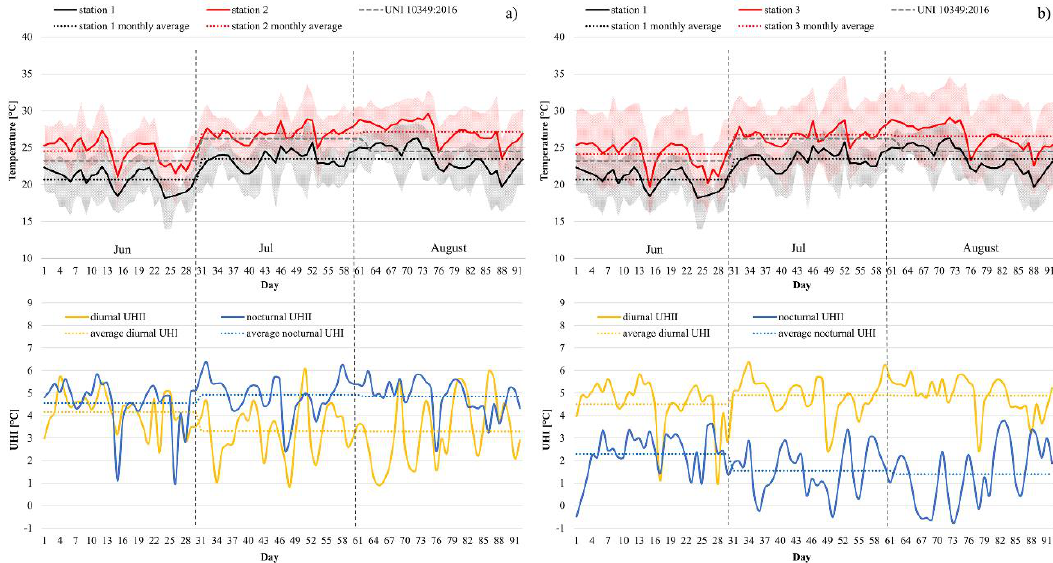
Figure 9. ( a ) Diurnal and nocturnal UHII at station 2 and comparison between stations 1 and 2 during June, July, and August; ( b ) diurnal and nocturnal UHII at station 3 and comparison between stations 1 and 3 during June, July, and August.